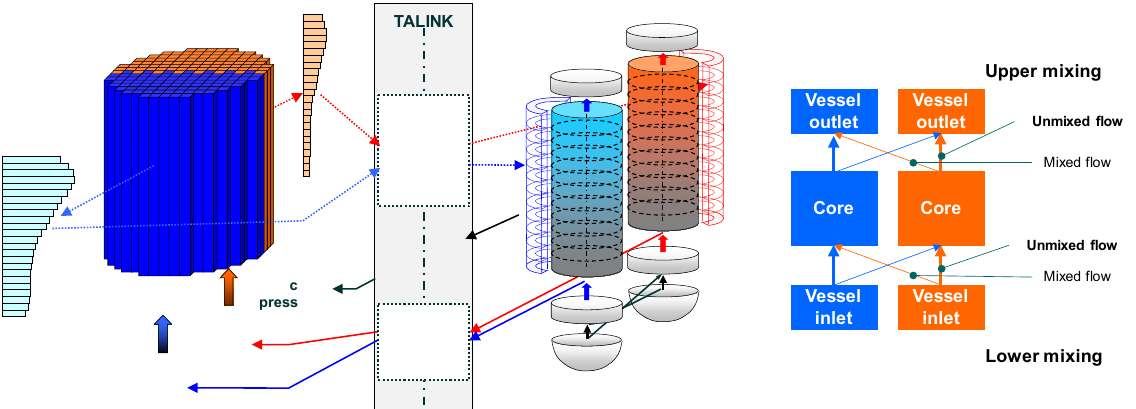
Figure 2. Schematic coupling between core neutronics and system